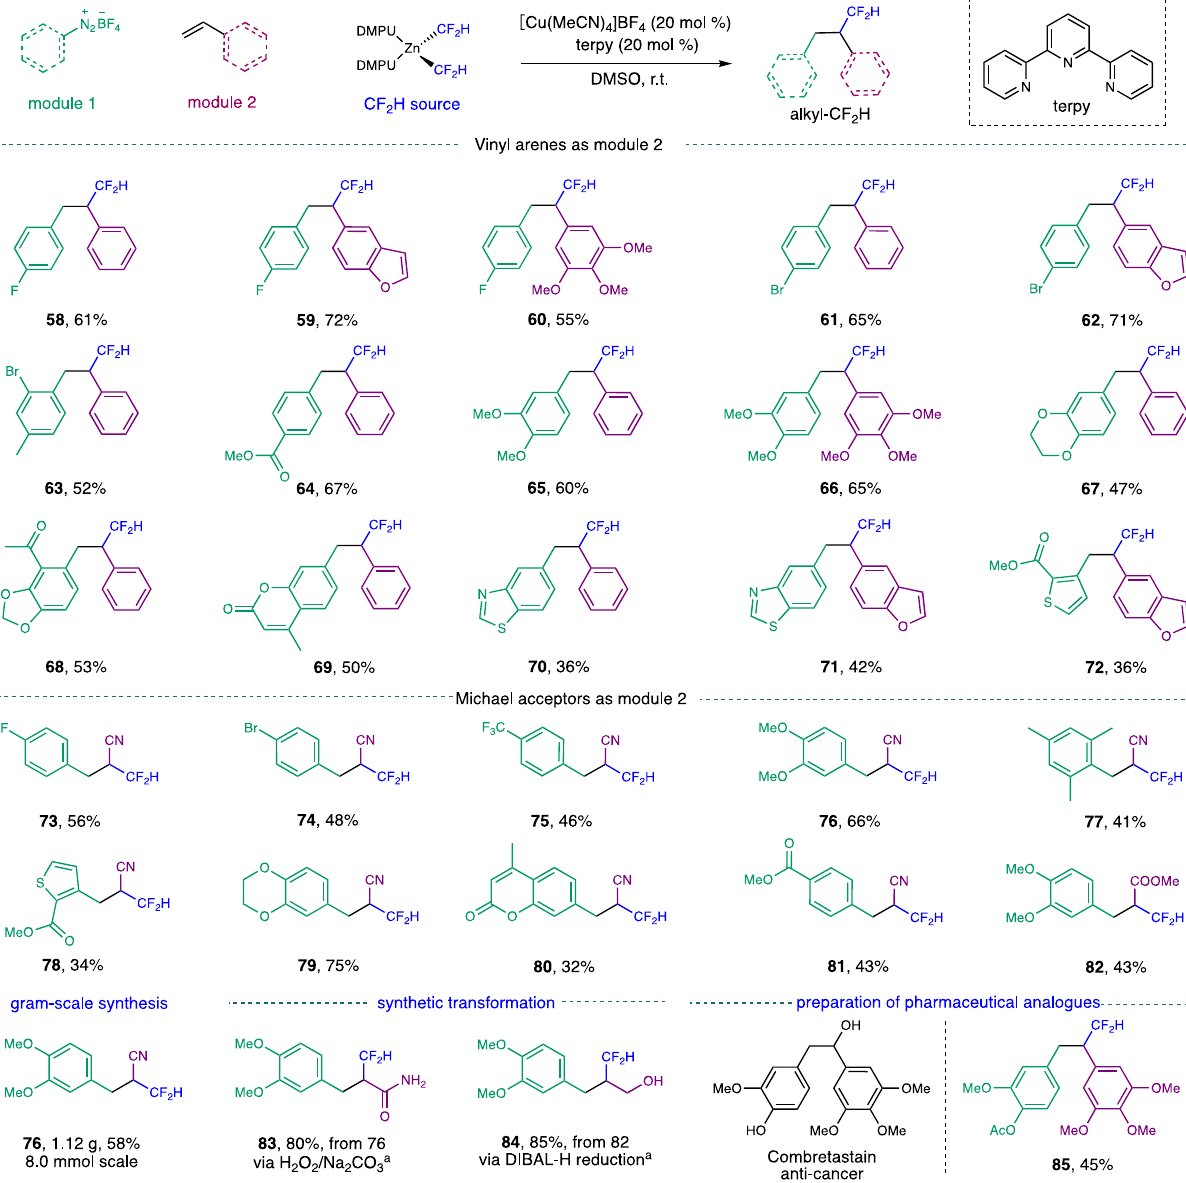
Fig. 5 Copper-catalyzed di fl uoromethyl-arylation of alkenes. Reactions were run with 0.25 mmol of aryl diazonium salts (1.0 equiv.), 0.75 mmol of alkenes (3.0 equiv.), 0.2 mmol of (DMPU) 2 Zn(CF 2 H) 2 (0.8 equiv.), CuCl (20 mol%), and terpy (20 mol%) in 1 mL of DMSO at r.t., isolated yields. a See Supplementary Method 1 for detailed conditions. terpy, 2,2 ʹ ;6 ʹ ,2 ʺ -terpyridine; DMSO, dimethyl